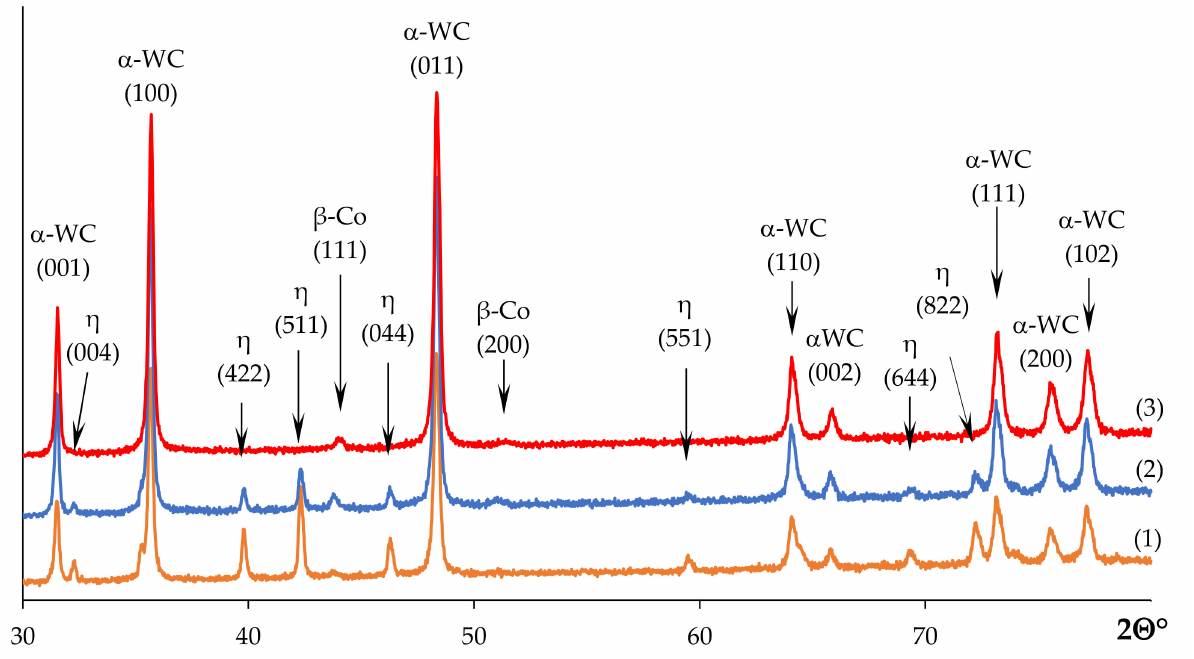
Figure 10. XRD results for WC-10Co specimens with various graphite concentrations obtained by solid-phase sintering of nanopowders. Line (1)—0.5 wt.%, (2)—1.0 wt.%, (3)—1.5 wt.%